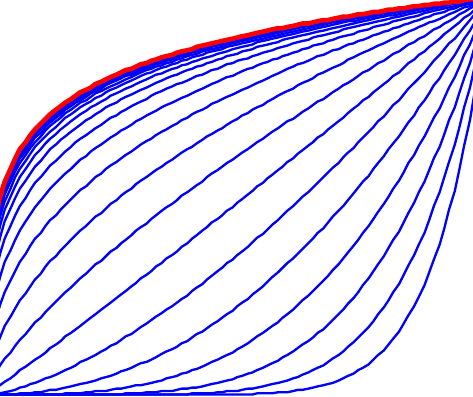
Figure A1. Steady-state wellbore-centric radial temperature profiles T(r) = T 0 + (T 1 − T 0 )((r/r 0 ) Pe − 1)/ ((r 1 /r 0 ) Pe − 1) for range of fluid flow velocities associated with Peclet numbers P e = r 0 φ v 0 /D. Fluid fow is in a cylindrical section with radius r 1 at fixed temperature T 1 and a central wellbore of radius r 0 at temperature T 0 . Fluid advection velocity fields are determined by fluid velocity v 0 at the central wellbore, v(r) ~ r 0 v 0 /r. The amount of heat carried by the fluid is proportional to the porosity φ of the flow medium.